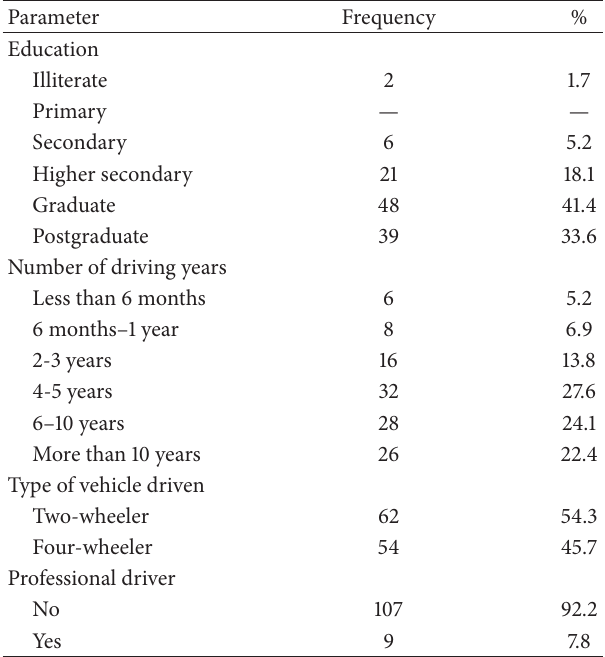
Table 1: Sociodemographic